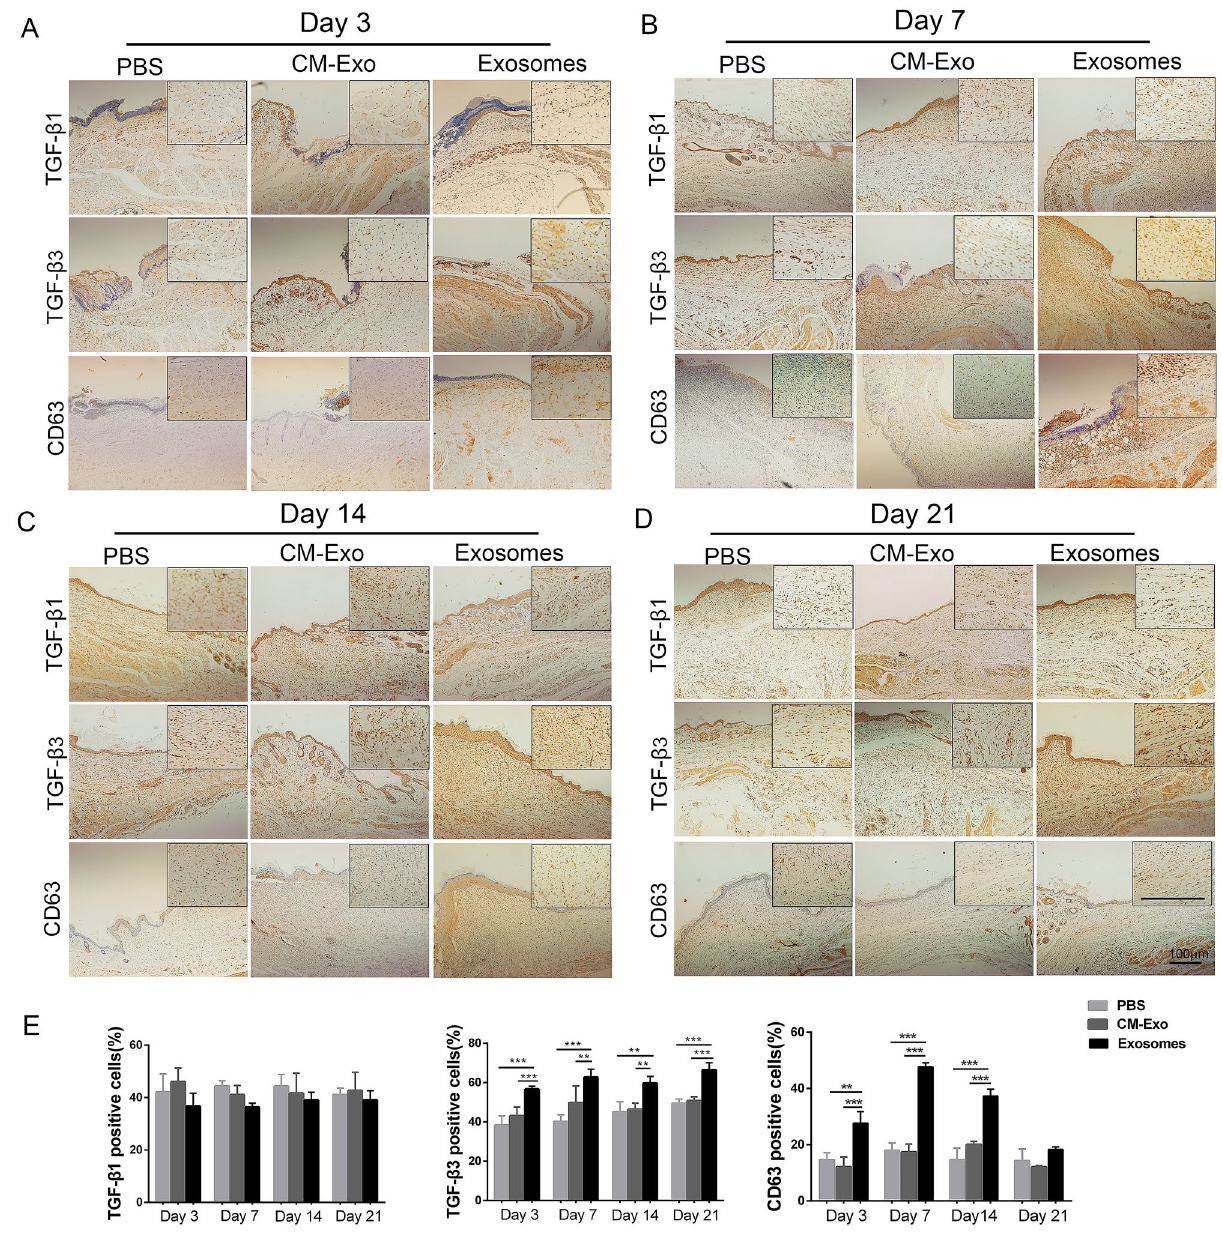
Figure 1. The original incorrect version of Figure